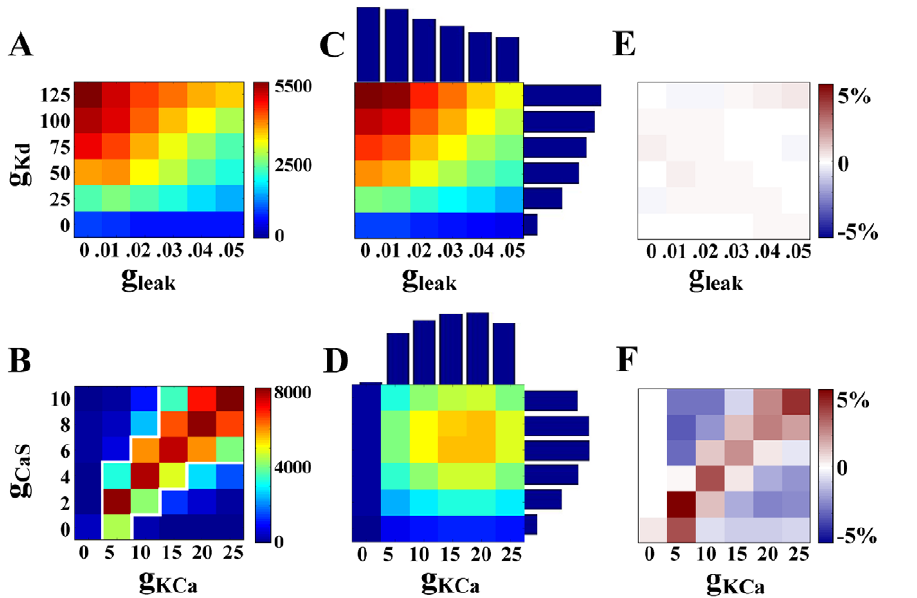
Figure 3. Ramp-type conductance relationships can be fully explained by the independence assumption, whereas linear correlations cannot. (A) The activity type ‘‘periodic bursters with duty cycle 0.1–0.2’’ tends toward high values of g Kd and low values of g leak ( x 2 =253, r =0.006). Colors represent the number of models on each grid point. All maximal conductance units are mS/cm 2 . For each plot, no assumptions are made about the values of the other six conductances. (B) The same activity type shows a linear relationship between the CaS and KCa conductances ( x 2 =72,330, r =0.627). The white outline encases correlation boundaries as used for creating a correlation-based population, see methods. (C,D) Data generated under the independence assumption. 1-D histograms protrude from the axis of the conductance they represent. The resulting independence matrix was generated by multiplying the two 1-D histograms, then scaling by total number of models in this activity group (see Methods). Color scale is the same in A and C and in B and D, respectively. (E,F) Difference matrix. The independence matrix (C,D) was subtracted from the actual data (A,B). Colors in (E,F) represent percent difference between independence matrix and actual data at each grid point.